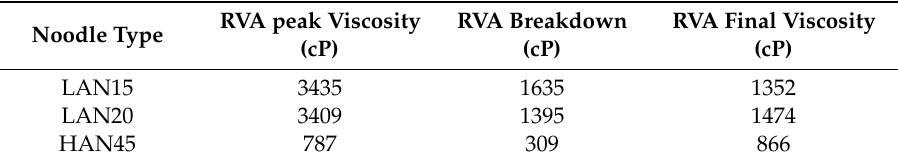
Table 2. Wheat flour quality characteristics.